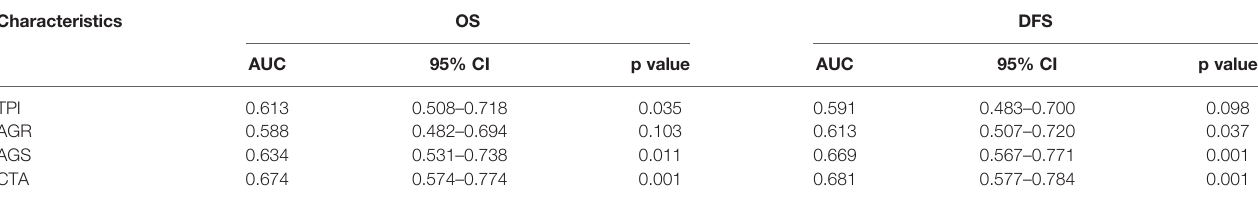
TABLE 4 | The AUCs of TPI, AGR, AGS, and CTA for OS and DFS prediction based on the ROC results. Characteristics